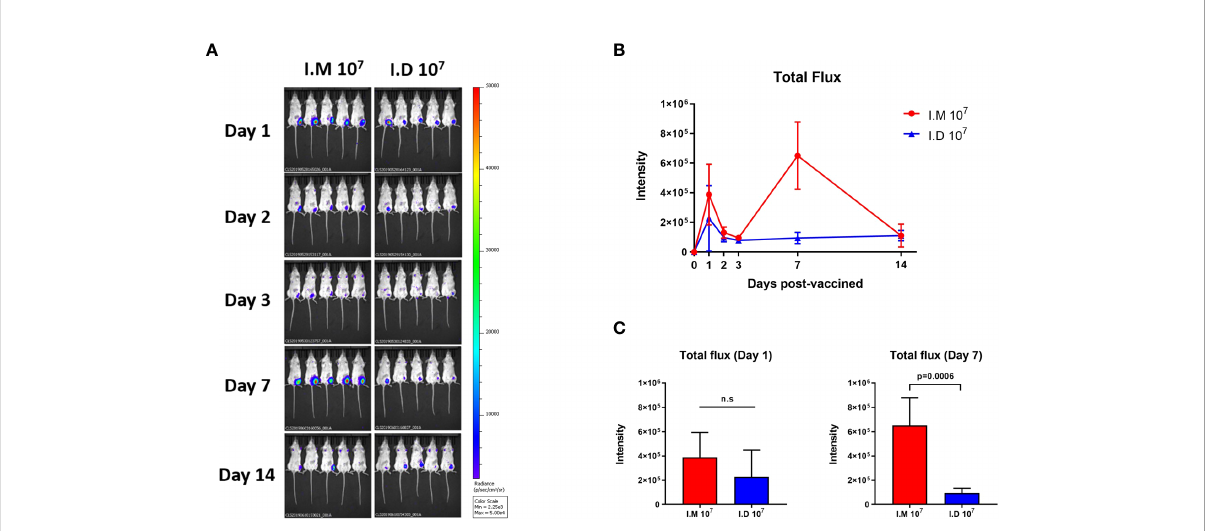
FIGURE 5 Intramuscular injection exhibited a prominent effect on antigen expression. Ad5-Luc is injected intramuscularly or intradermally and the photo fl ux was detected at indicated times. (A, B) Bioluminescent images were acquired and Total fl ux was calculated at day 1, 2, 3, 7 and 14 post- injections. (C) Values for average radiance at each time point are compared. Data is represented as mean ± SD. Statistical signi fi cance was determined using unpaired t' test. n.s indicated no signi fi